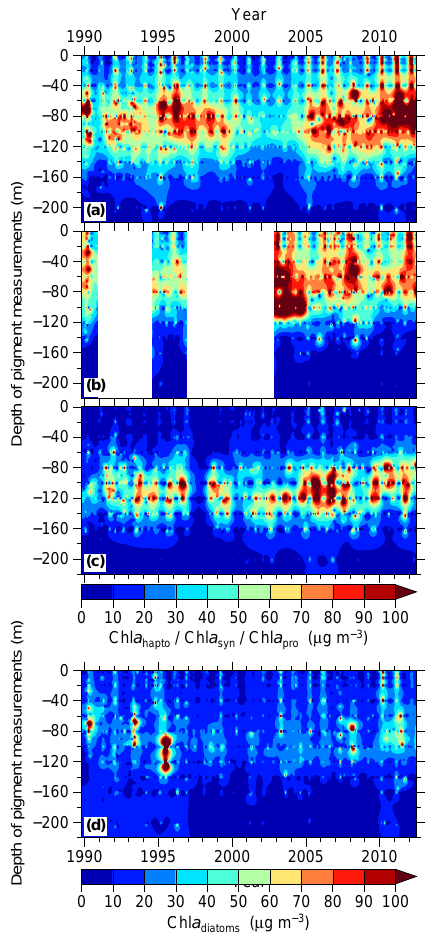
Figure 4. Temporal evolution of the vertically resolved Chl a concentration from the main phytoplankton present at BATS de- rived from signature pigments from 1990 to 2012: (a) Chl a hapto , (b) Chl a syn , (c) Chl a pro , and (d) Chl a diatoms .